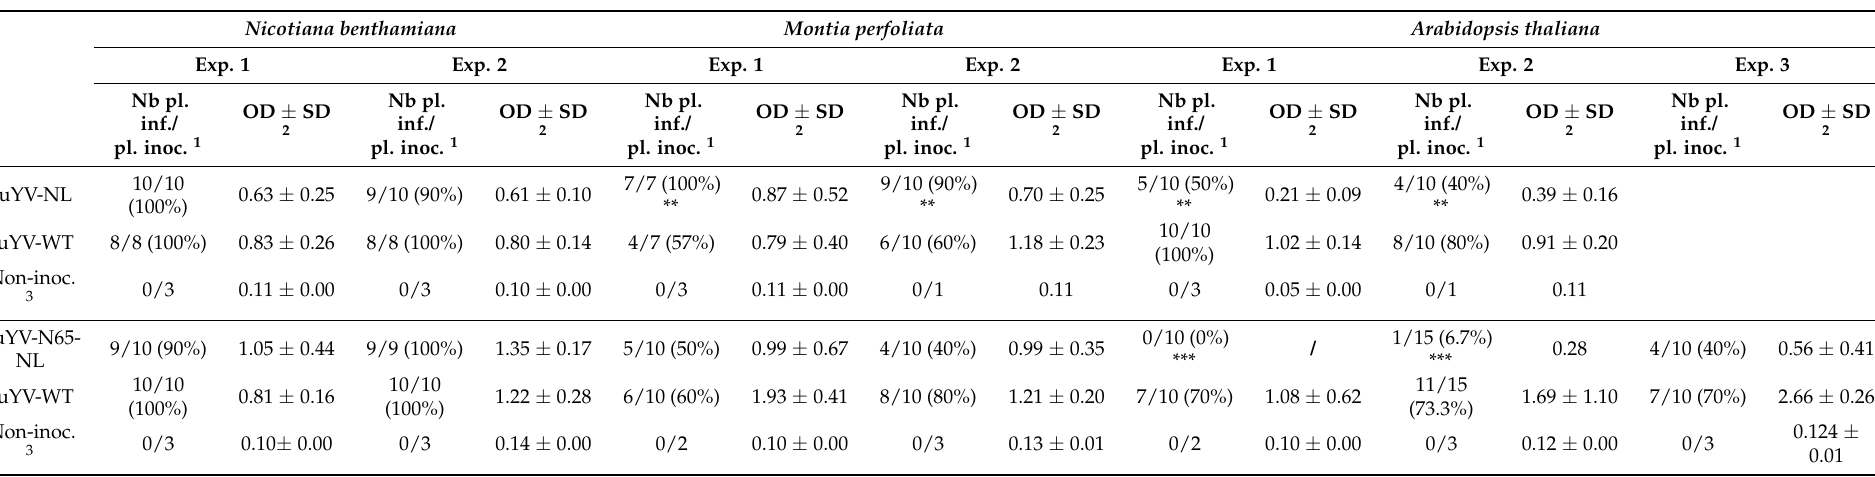
Table 2. Detection by double antibody sandwich (DAS)-ELISA of wild-type TuYV (TuYV-WT), TuYV-NL, and TuYV-N65-NL in non-inoculated (systemically infected) leaves of three plant species in different experiments